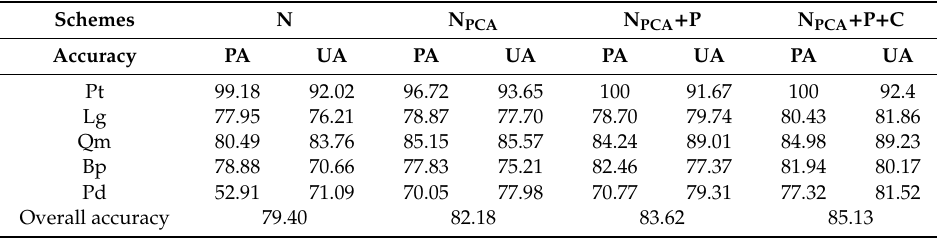
Table 3. Producer’s accuracy (PA) and user’s accuracy (UA) of forest mapping for individual tree species and overall accuracy based on di ff erent schemes. N indicates the original 10-day NDVI time series, N PCA stands for transformed patterns of 22 PCs from PCA analysis based on 10-day time series of NDVI, P indicates the phenological metrics derived from 10-day NDVI images, and C means the contrast of texture